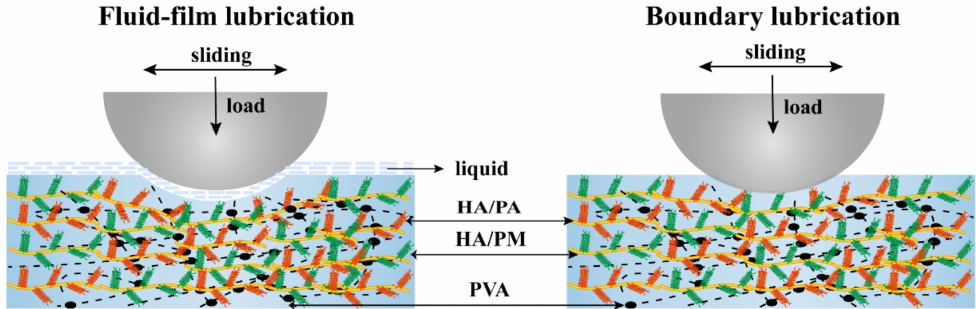
Figure 6. Schematic diagrams of the lubrication mechanism of the HPX/PVA hydrogels. Mixed lubrication due to the coexistence of boundary lubrication and fluid-film lubrication.